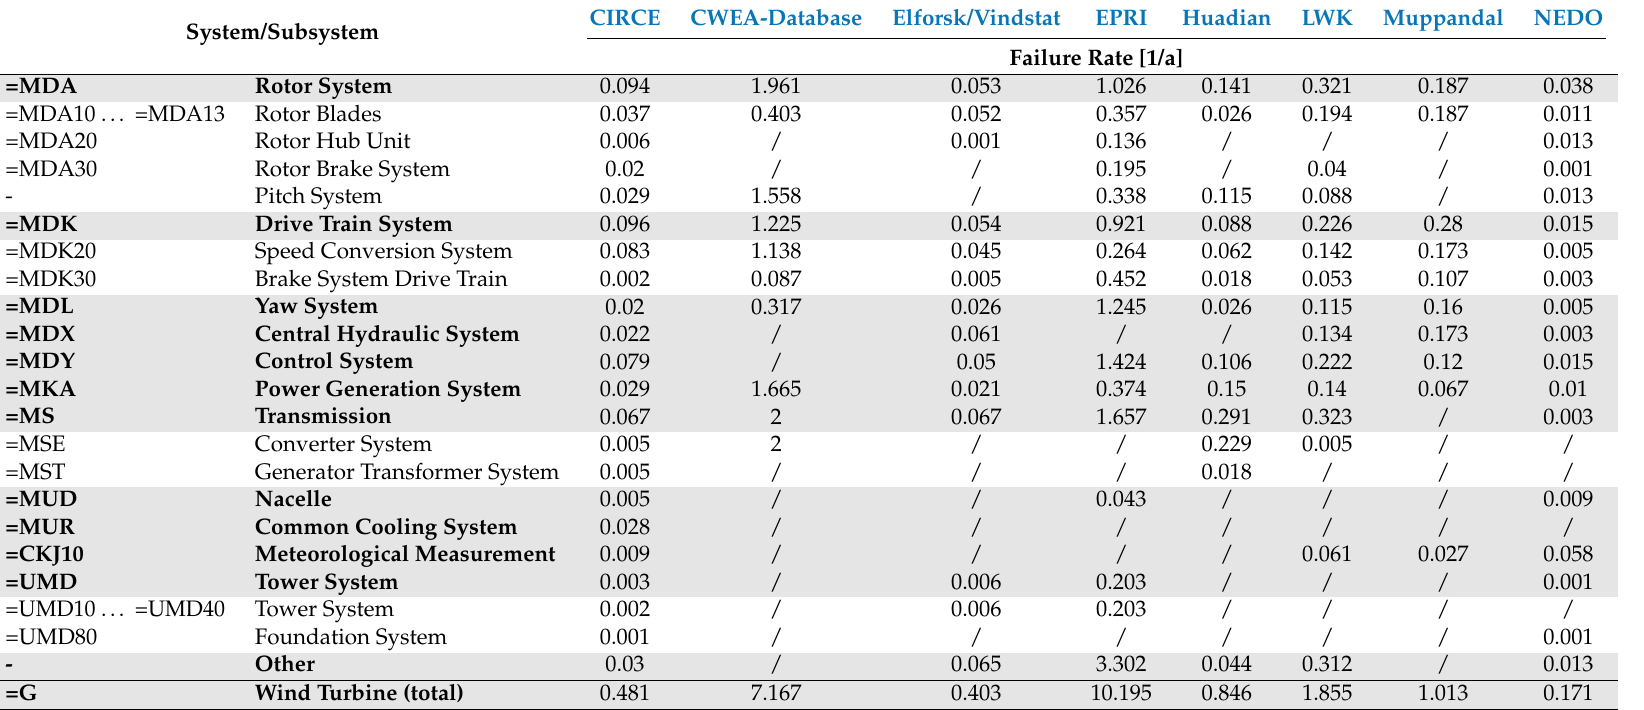
Table 4. Average failure rate per WT as published by different initiatives (part